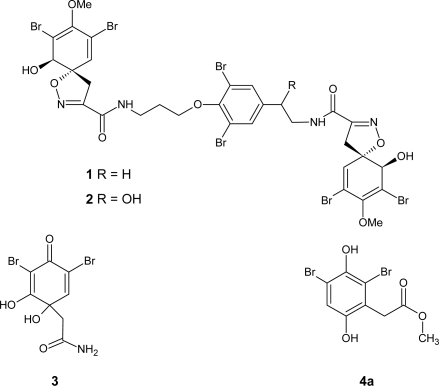
Bromotyrosine metabolites 1–3 and methyl (2,4-dibromo-3,6-dihydroxyphenyl) acetate (4a).